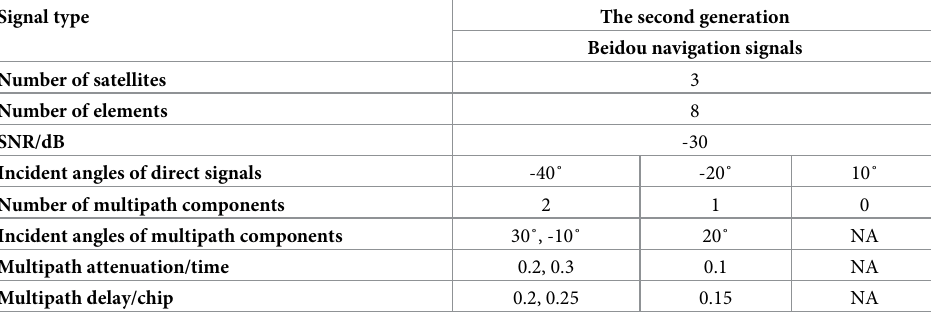
Table 1. General simulation conditions for multipath signals of satellite